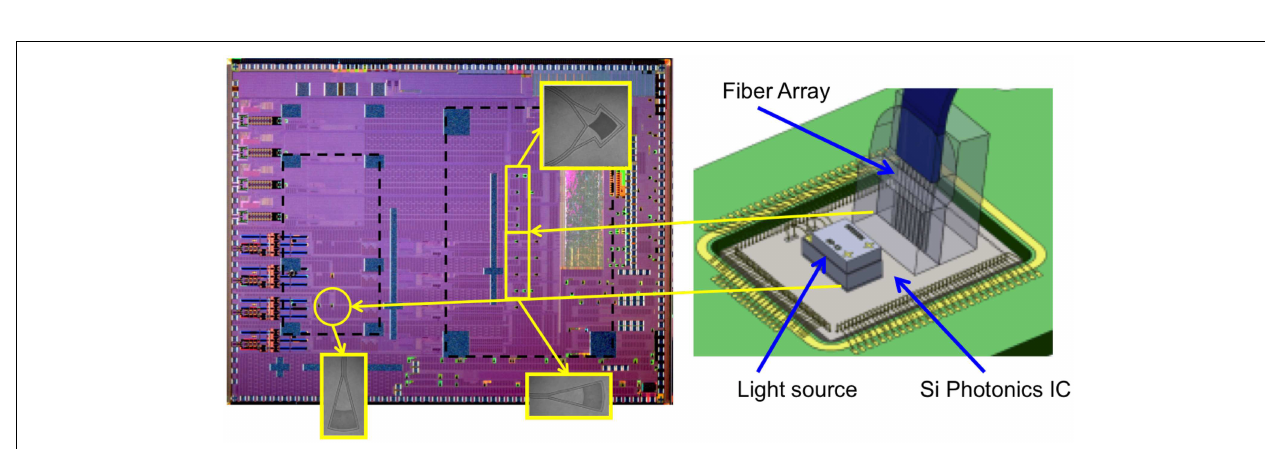
FIGURE 14 | Silicon photonics 8-PSM transceiver. Courtesy of Luxtera.